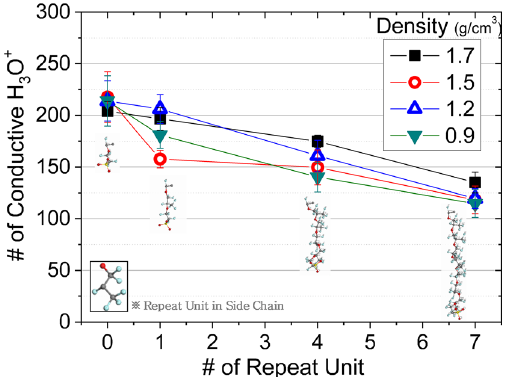
Figure 6. Structural variations in PFSA side-chains affect the conductive state of hydronium. Shorter side- chains were associated with more conductive H 3 O + . Irrespective of membrane density, the morphologies of the chain and side-chains significantly affected ionic movement.